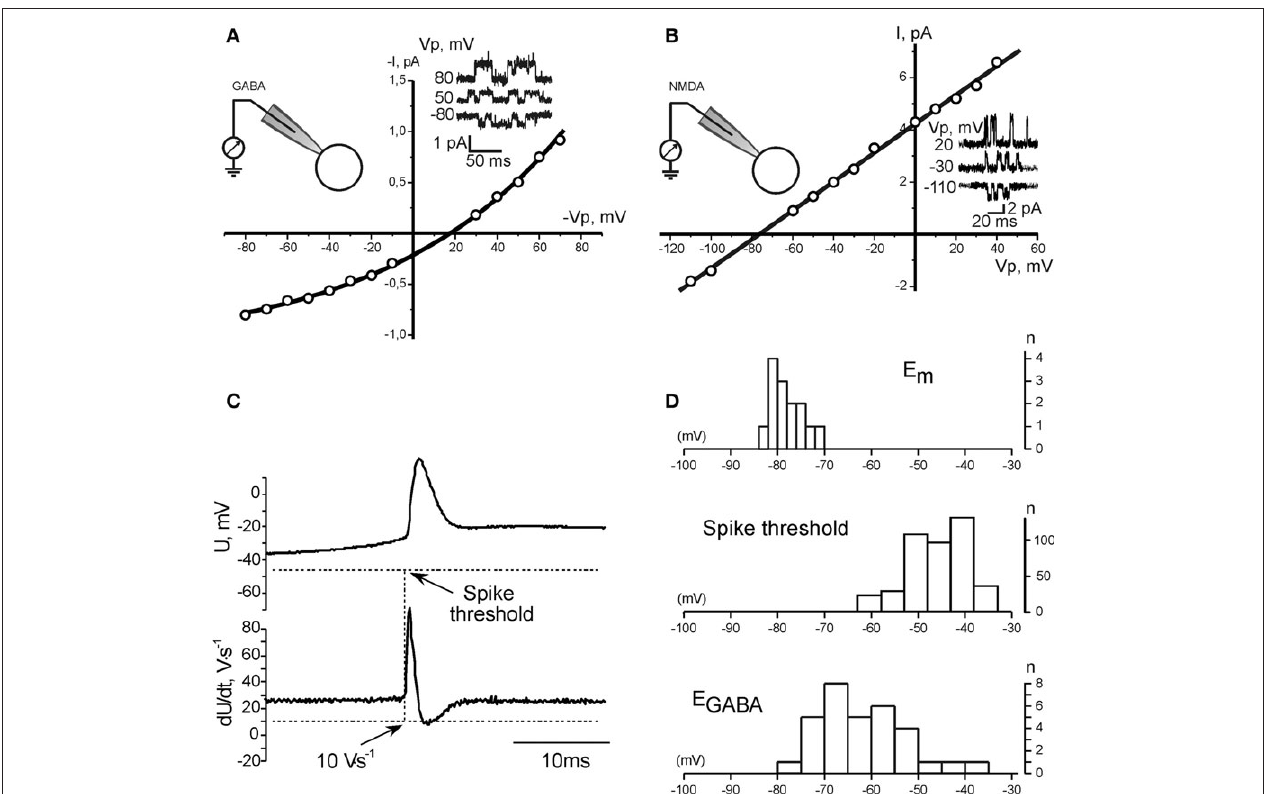
channel openings at different pipette potentials ( V ) are shown in insets. p (C) Measurement of the action potential threshold in whole-cell current-clamp recordings. (D) Summary plot of the resting membrane potential, GABA reversal potential and the action potential threshold in P2–5 CA3 pyramidal neurons.